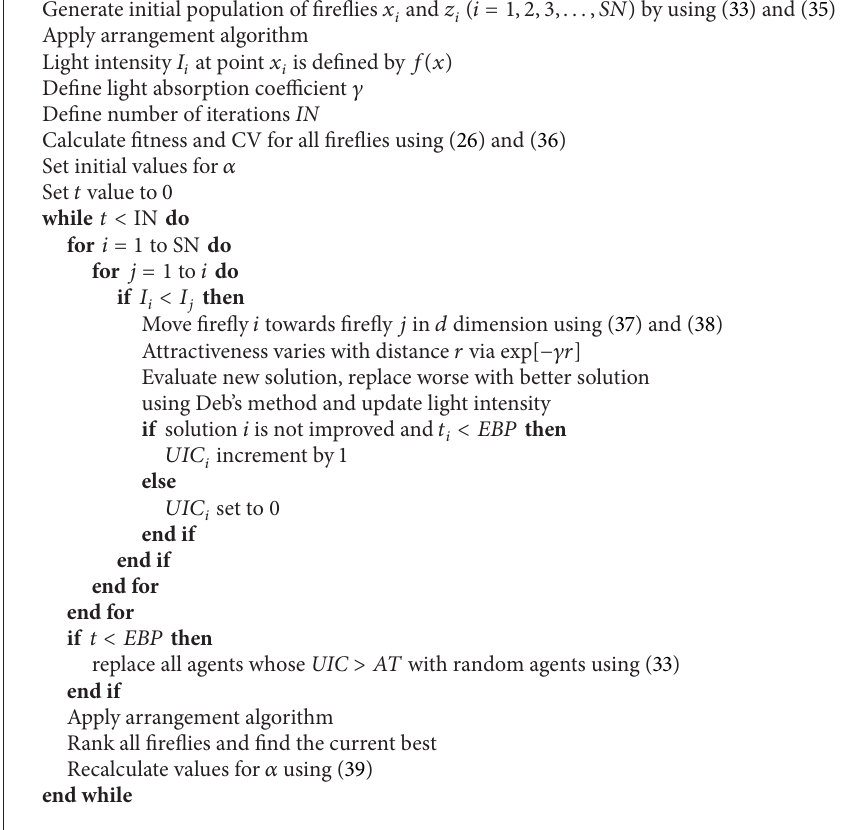
Algorithm 3: Modified firefly